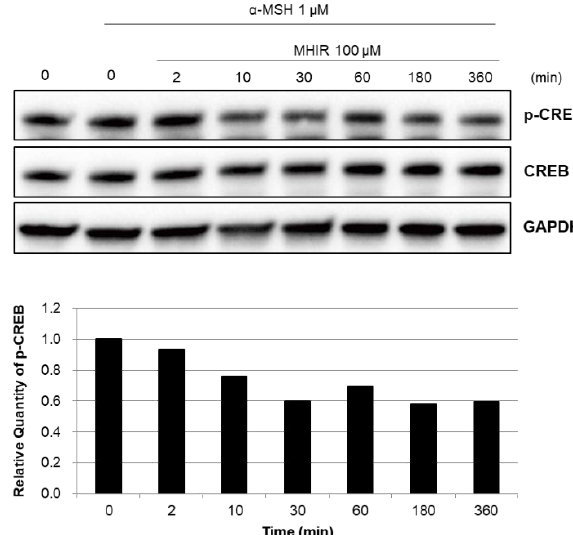
Figure 5. Effects of the MHIR peptide on melanogenesis-related signaling. α-MSH-treated B16F10 cells were incubated with MHIR (100 μM) for 0~360 min, after which the whole-cell lysates were analyzed via western blotting using specific antibodies. Equal protein loading was confirmed by probing for GAPDH expression. The relative quantities of phosphorylated CREB were normalized to that of total CREB. This graph is a representative result of three independent experiments.